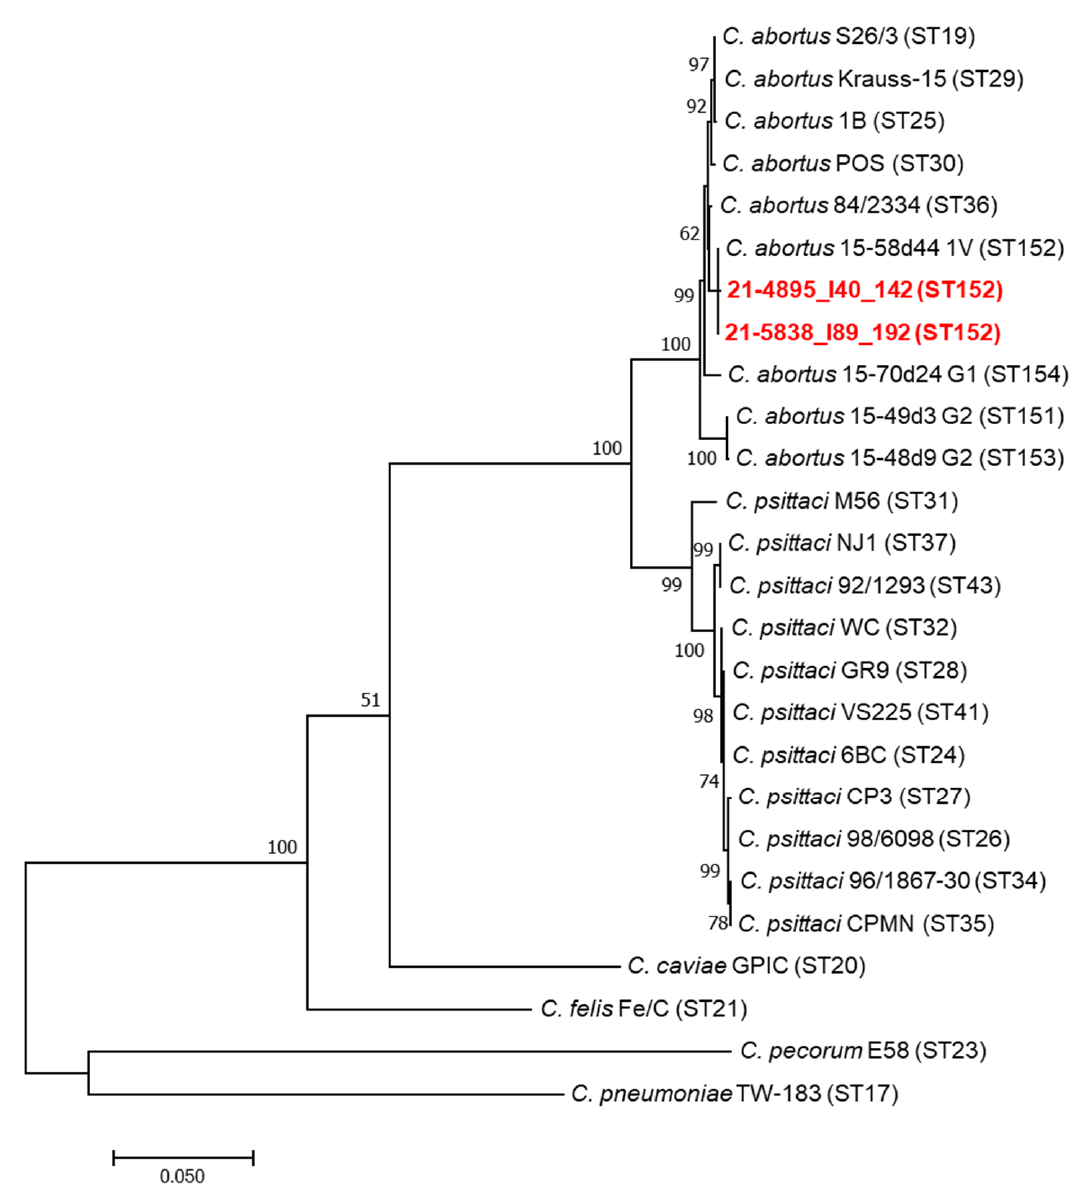
Figure 1. Phylogenetic analyses of multilocus sequence typing (MLST) concatenated sequences of Chlamydia. Concatenated sequences (3098 nucleotides) were aligned and analysed in MEGA7. Phylogenetic trees were constructed by using the maximum likelihood method based on the general time-reversible model. Bootstrap tests were for 1000 repetitions. Numbers on tree nodes indicate bootstrap values of the main branches. Horizontal line scale indicates the number of nucleotide substitutions per site. The MLST sequence type (ST) is indicated. The red colour represents the avian C. abortus strains analysed in this study.